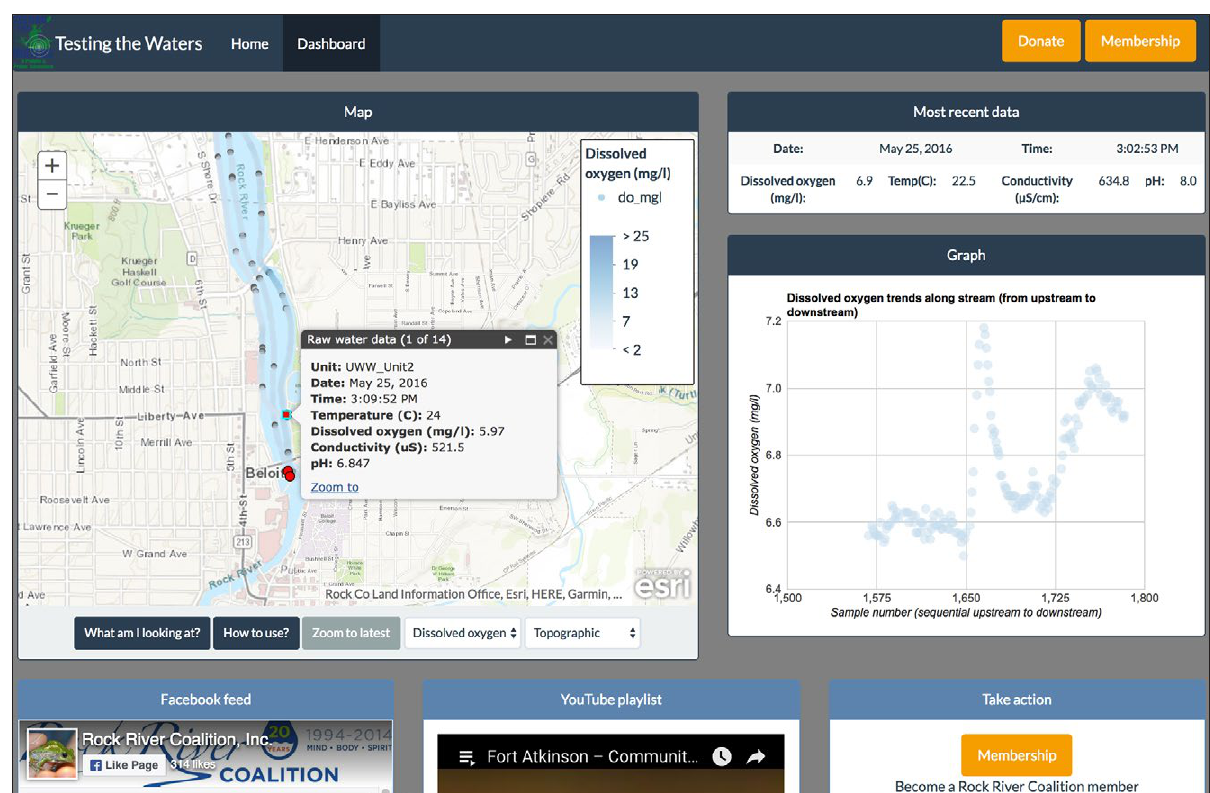
Figure 5: Testing the Waters website (http://testingwaters.org) showing the real-time data and map provided to the public during our event.